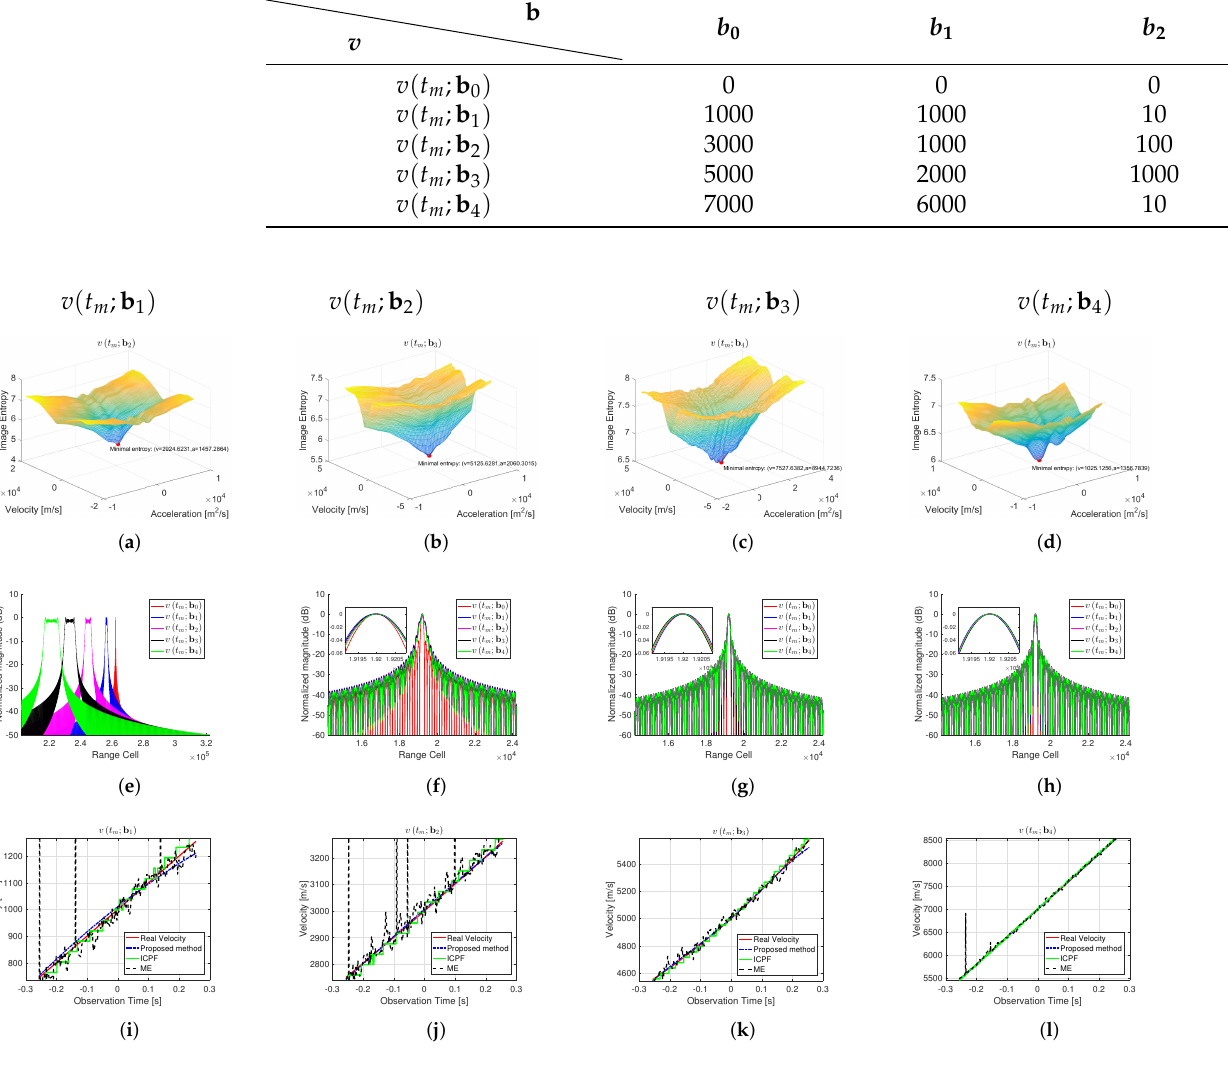
Figure 7. ( a – d ) Image entropy variation with velocity and acceleration; ( e – h ) range profiles of individual scattering points in ISAR images; and ( i – l ) velocity estimation and its true value of different high-speed compensation algorithms at different motion